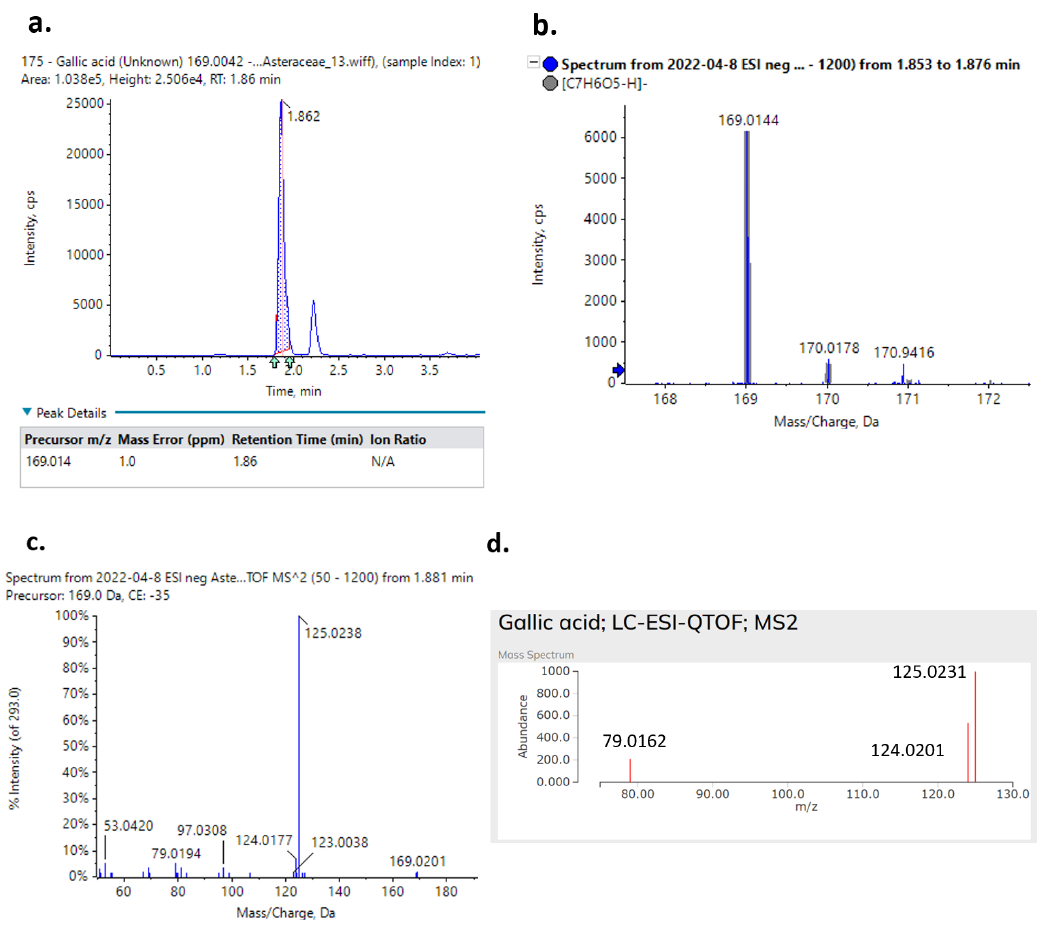
Figure 4. Gallic acid identification process. ( a ) The monitored XIC chromatogram. ( b ) The attained MS and ( c ) MS/MS spectra. ( d ) The available online MS/MS spectrum available on https://massbank.eu/MassBank/RecordDisplay?id=PR308148&dsn=RIKEN, last accessed 2 August 2022.